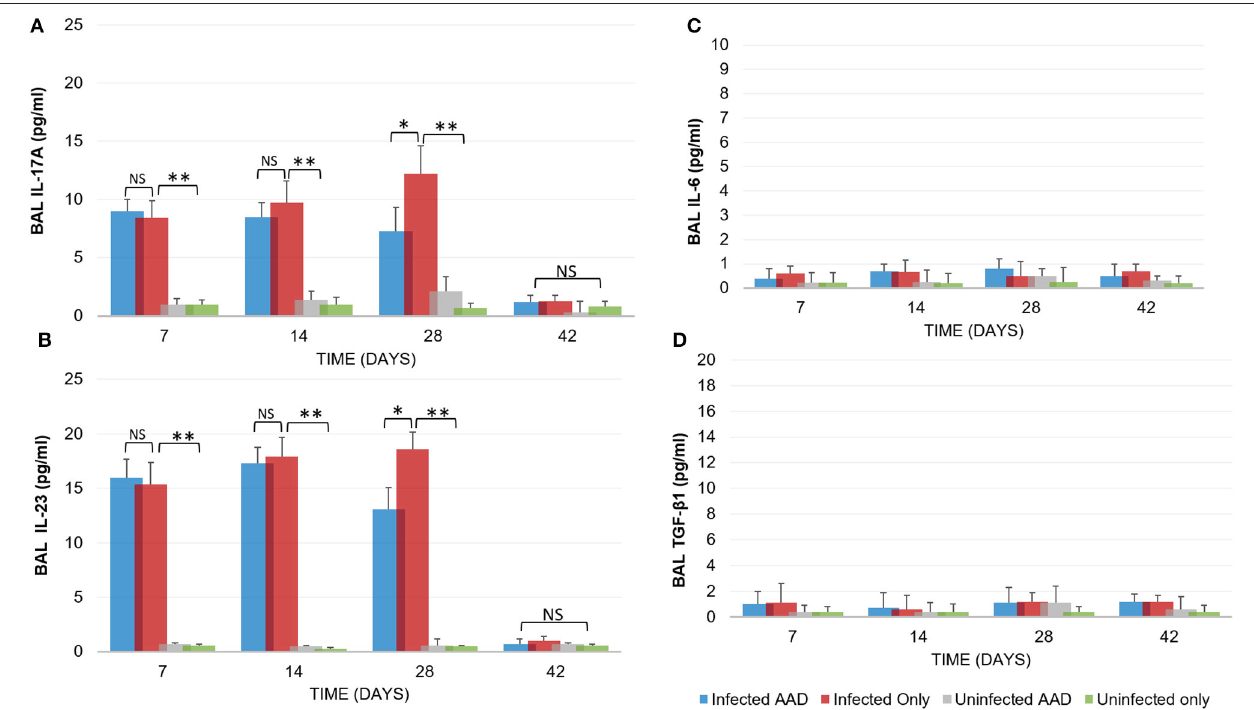
FIGURE 5 | Inflammatory cytokine production. Infected animals displayed a moderate Th17 cytokine response (IL-17A and IL-23) in response to chlamydial infection (A,B) . However, no IL-6 production was seen in any animal group (C) . IL-17A and IL-23 levels diminished once chlamydial infections were cleared and TGF- β 1 was not produced (D) . Uninfected and AAD induced only animals produced no Th17 or TGF- β 1 cytokines. N = 5 animals for each treatment group. * P < 0.05, ** P < 0.0001. P -value. An independent-sample T -test was performed for uninfected controls compared to infected animals; NS represents a p -value that is not significant. Results are representative of 2 independent